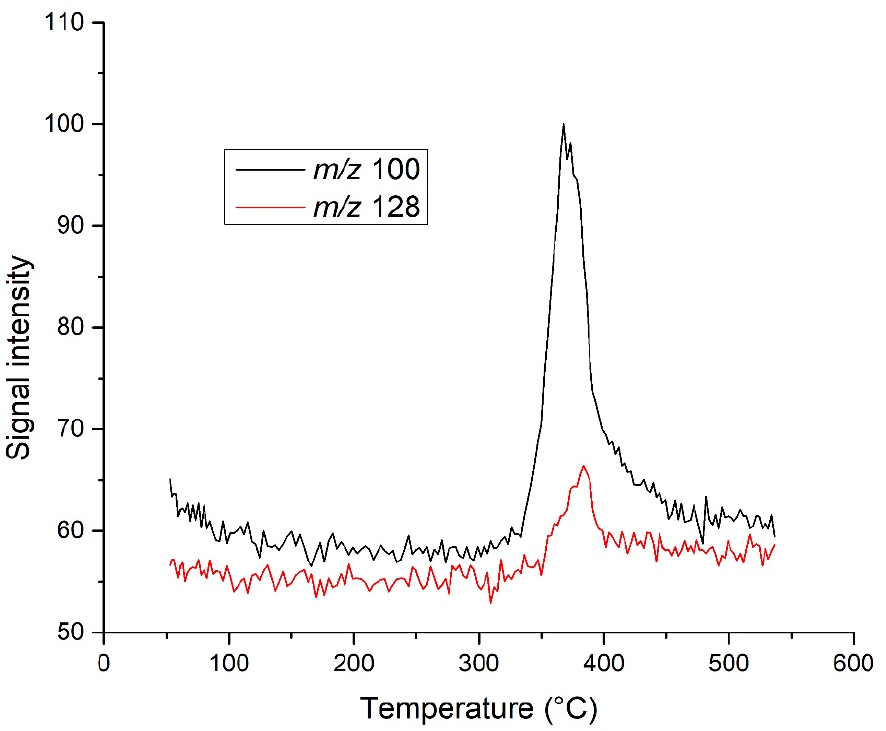
Figure 8. Comparison of peaks at m / z 100 and 128 obtained with the capillary heated at 280 °C.